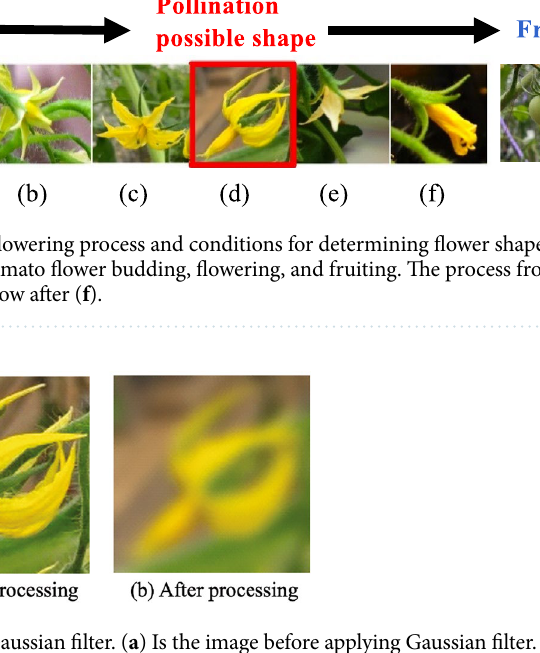
Figure 3. Gaussian filter. ( a ) Is the image before applying Gaussian filter. ( b ) Is the image after applying Gaussian filter.